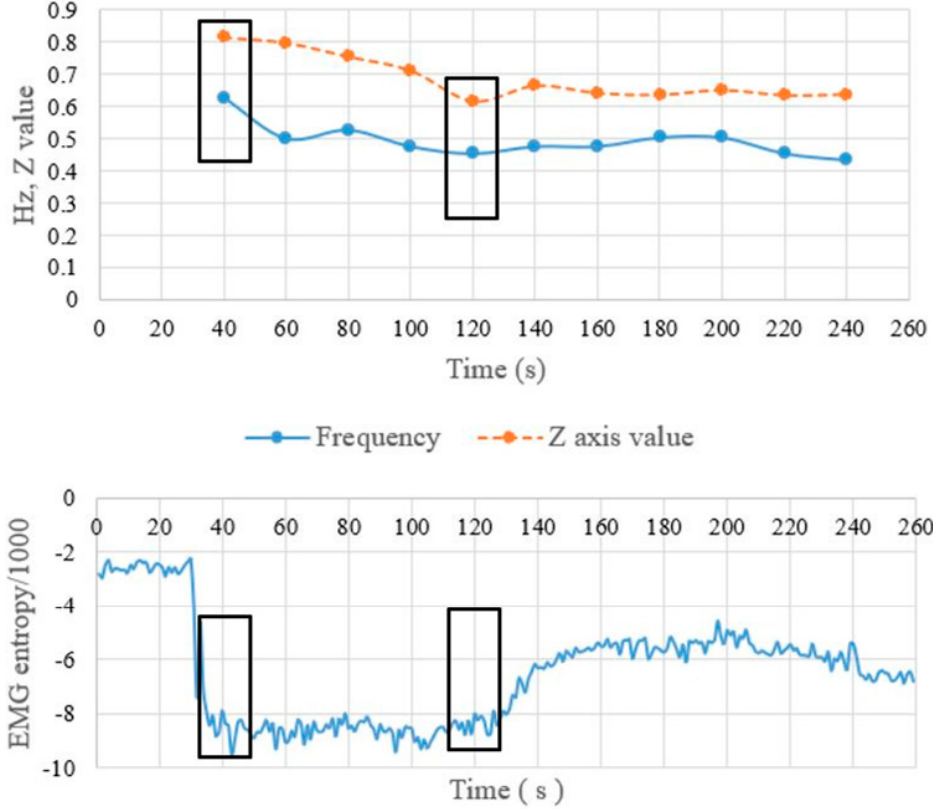
Figure 8. Comparison of Z -axis acceleration frequencies and entropy values ( top ). Number of leg lifts and leg lift force ( bottom ) EMG entropy